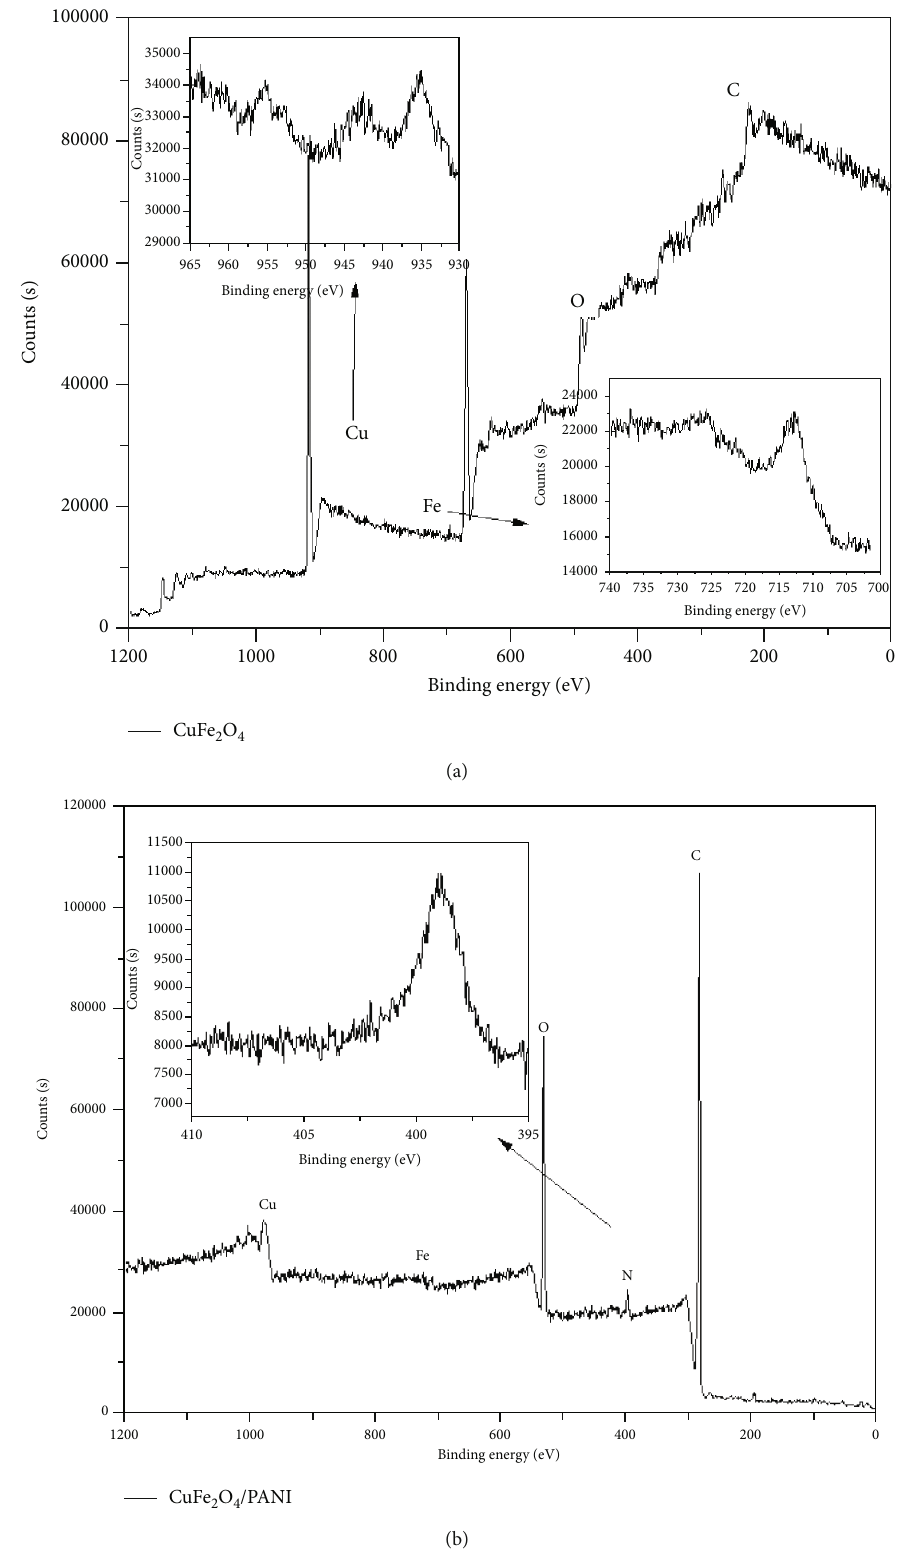
Figure 3: X-ray photoelectron spectroscopy of (a) CuFe